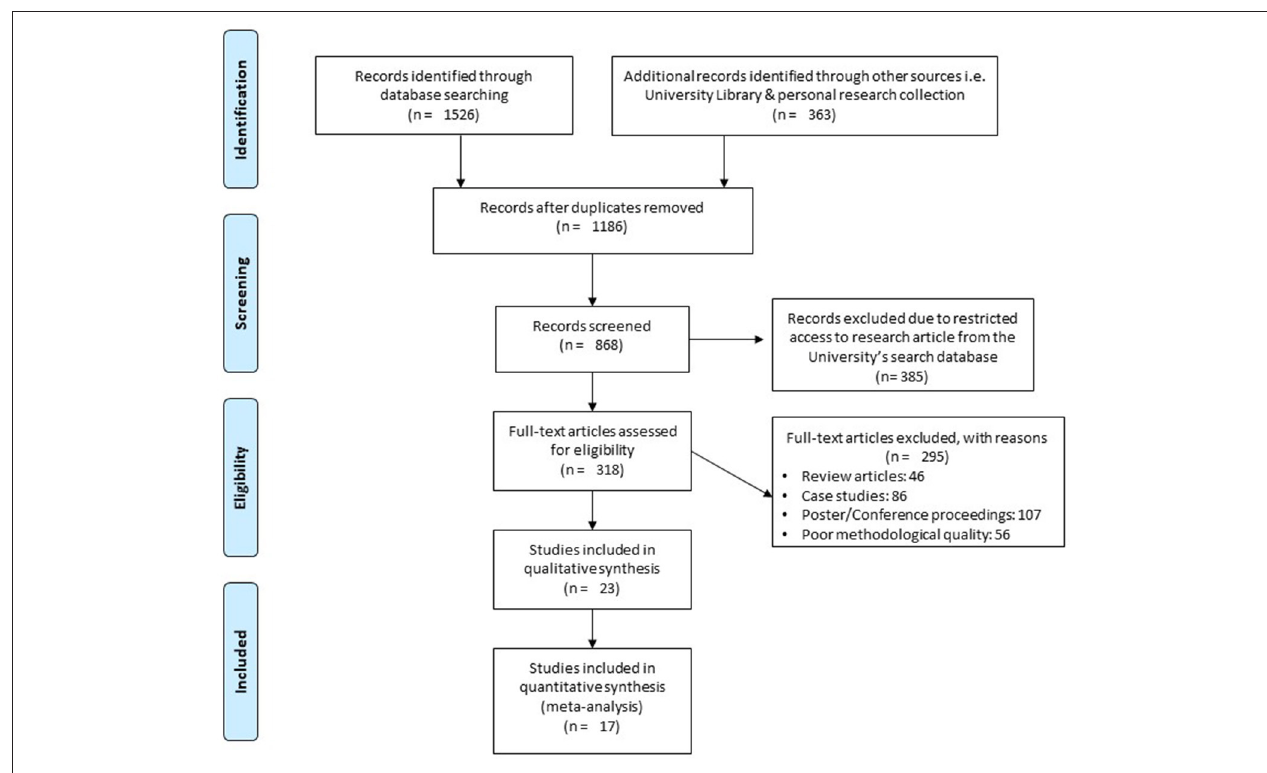
FIGURE 1 | PRISMA flow chart for the inclusion of